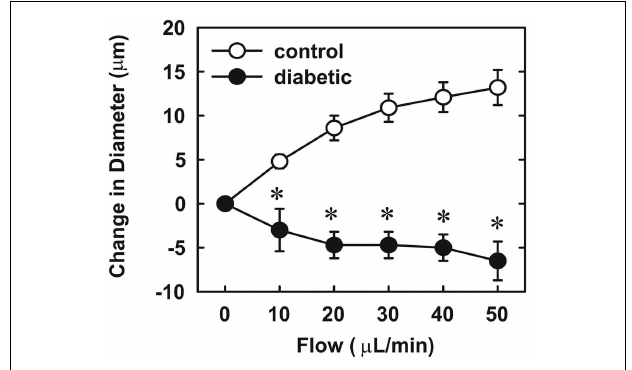
FIGURE 2 | Diabetes abolishes flow-dependent increases in internal diameter of gracilis muscle arterioles . Arterioles were isolated from control (open circles) or diabetic (closed circles) rats and exposed to graded levels of luminal flow. Results are expressed as mean ± SEM ( n = 3–5). * Statistically significant effect of diabetes ( p < 0.01).